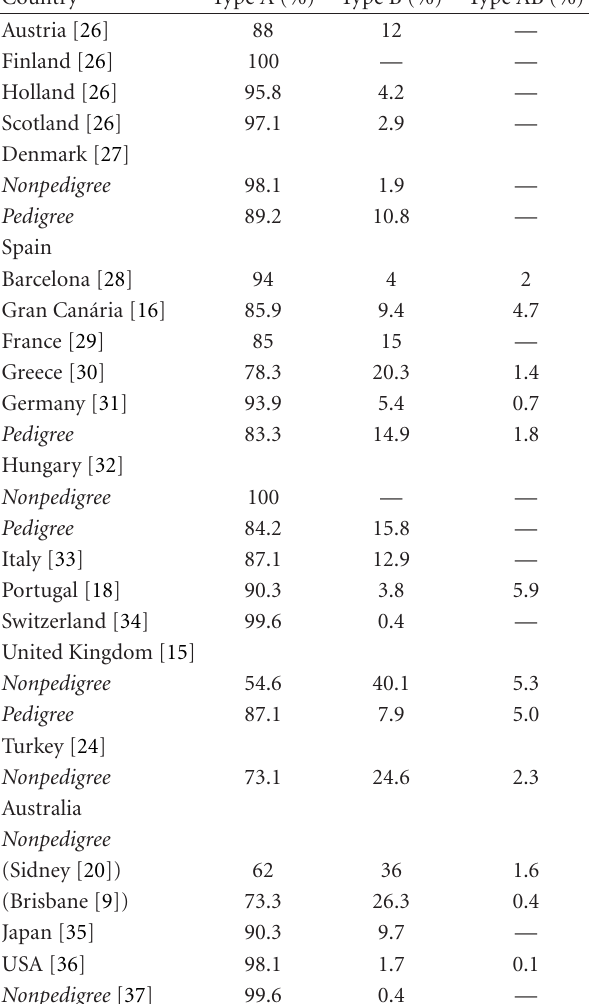
Table 2: Feline blood types geographical distribution. Country